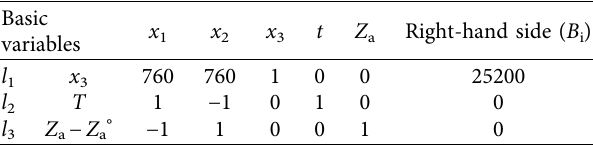
Table 2: Result of subtracting the 2nd row from the 3rd in the initial Simplex